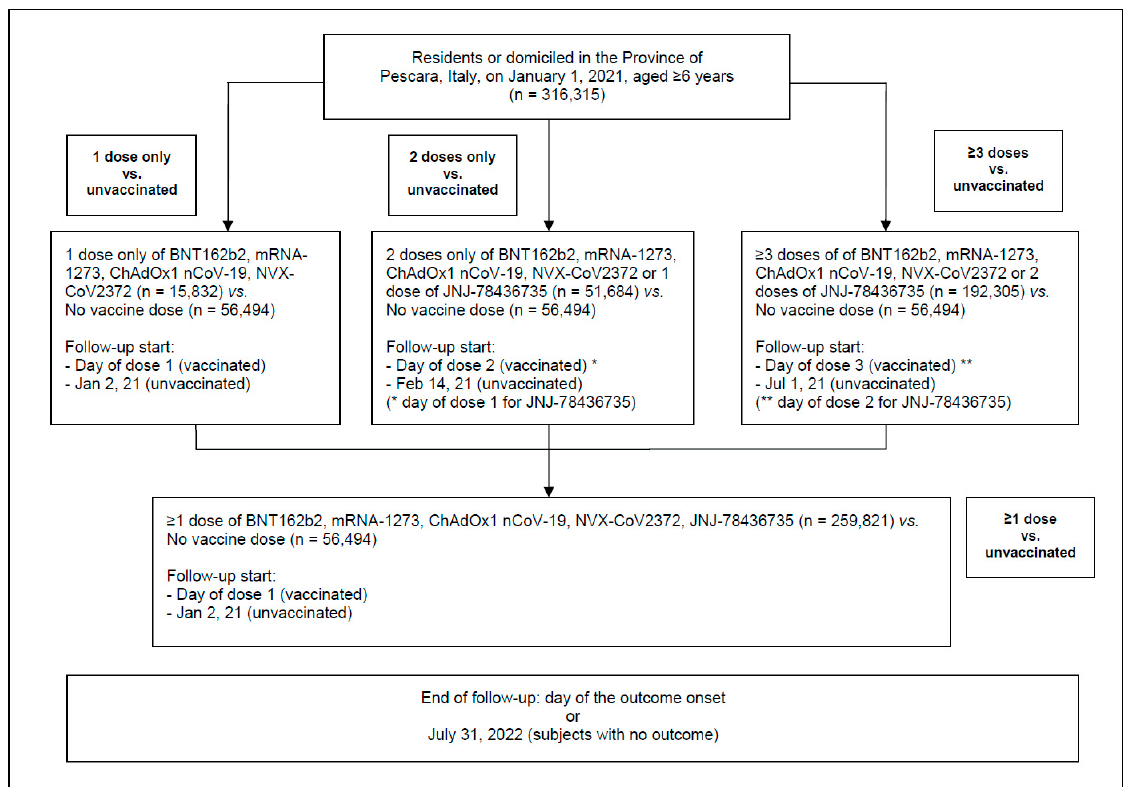
Figure 1. Flowchart of study participants.